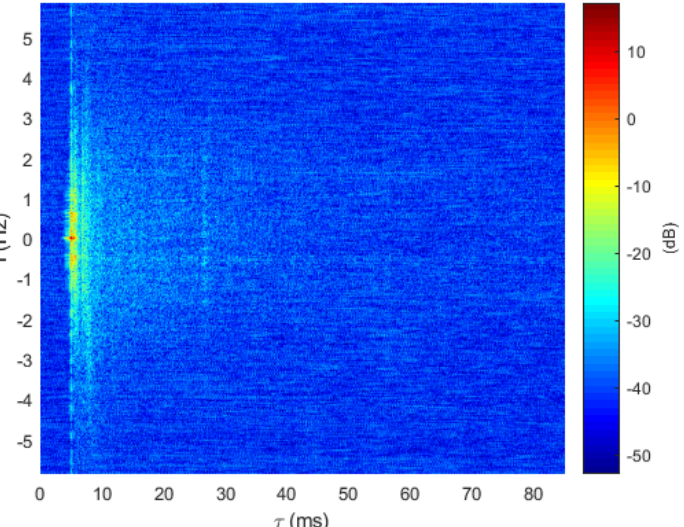
Figure 4. Delay-Doppler spread function extracted from channel sounding for D 1 = 200 m, roadstead of Brest,